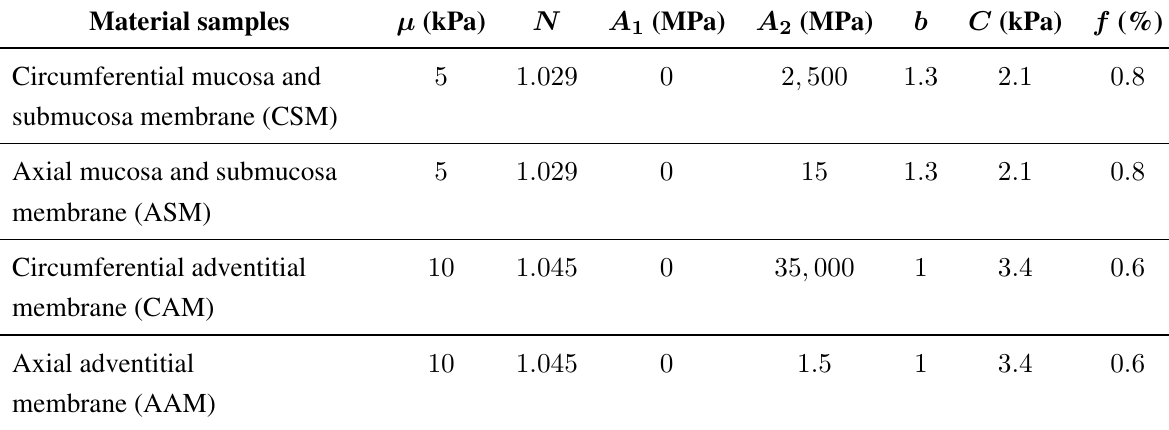
Table 2. Material constants used to fit the human tracheal experimental